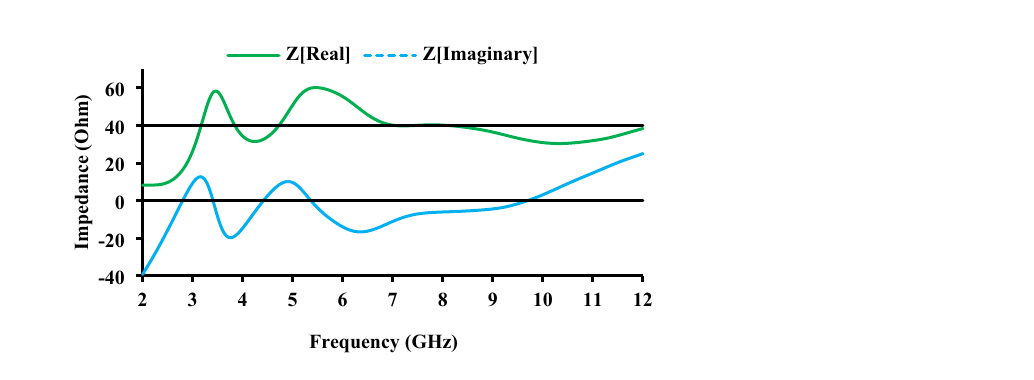
Figure 6. Impedance characteristics of the proposed